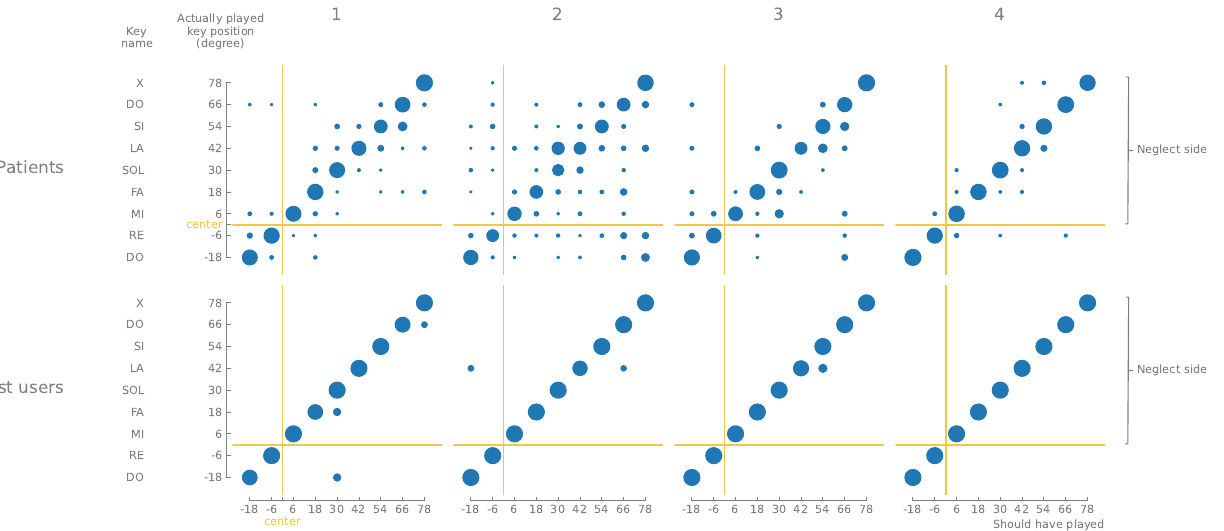
Figure 16. The distribution of the notes in the example sequence. The keys that should have been played, the played sequences and the keys that were played indicate that, overall, most keys were played correctly. Nonetheless, patients indicated a higher concentration of mistakes in general, mostly situated in their neglected